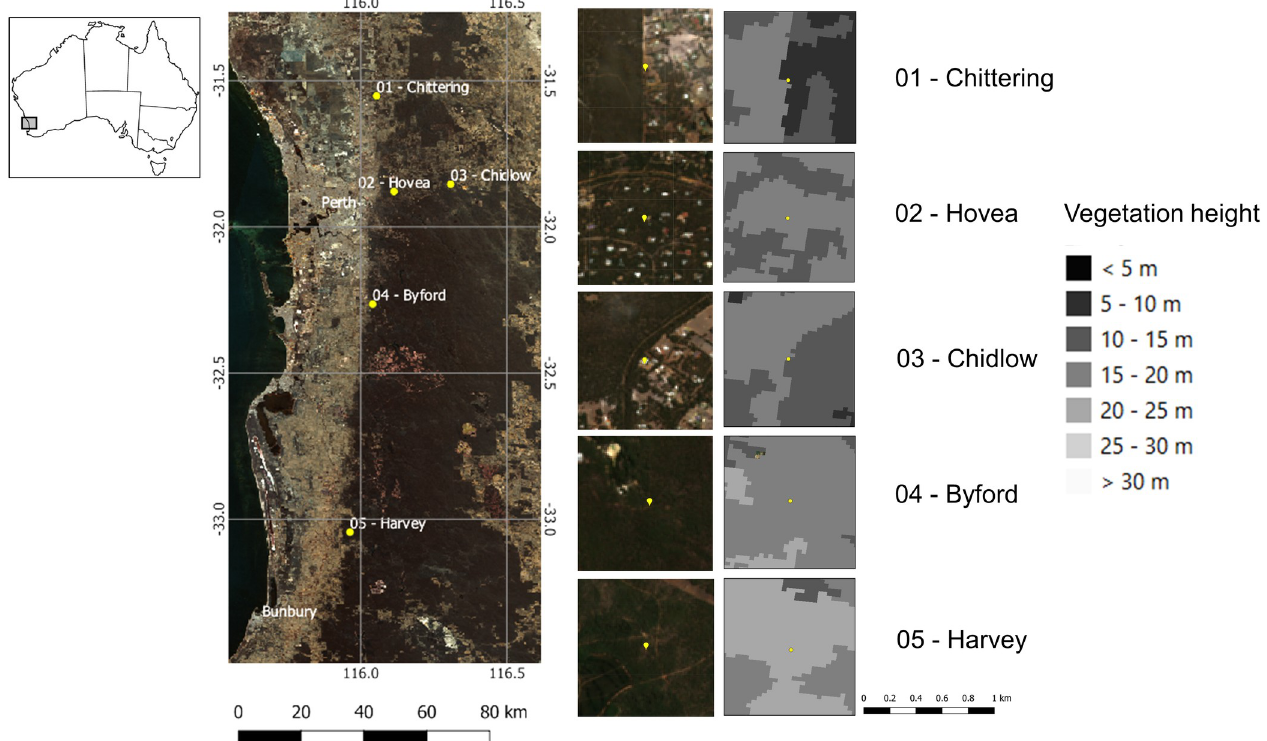
Fig 1. Sampling sites and canopy height. Distribution of the five study sites in the Eucalypt native forest according to ABARES [36] in South Western Australia. Canopy data (vegetation height) derived from Scarth [37]. Satellite imagery are Copernicus Sentinel Data [38].